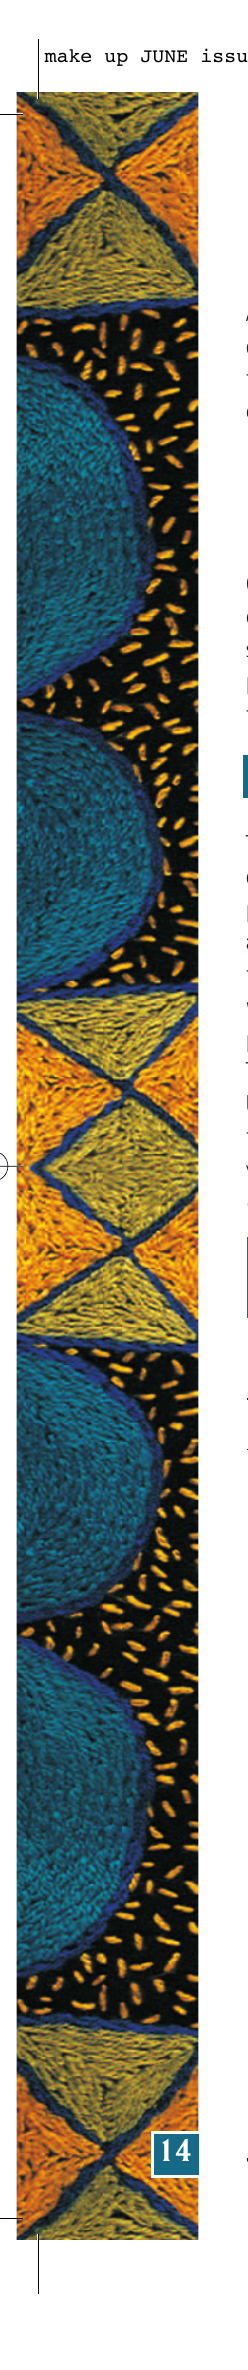
count category and WHO stage.